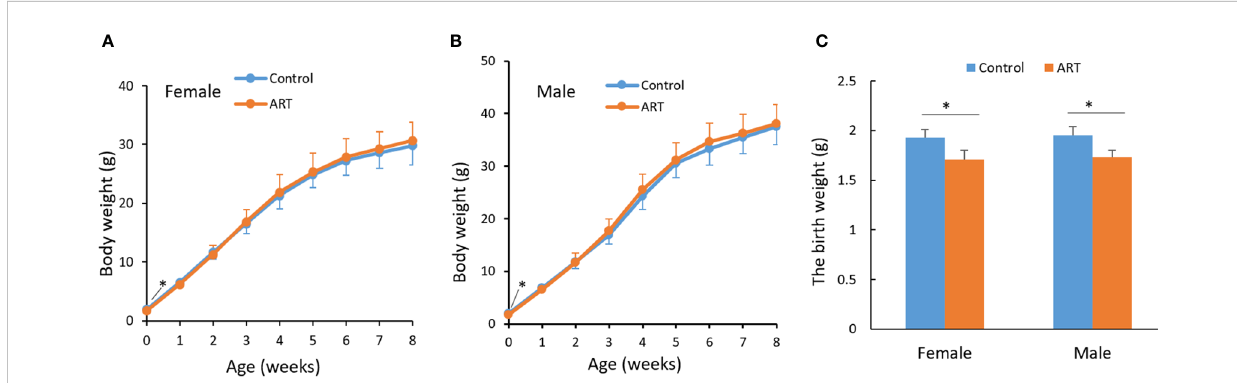
FIGURE 1 Growth curve of mice within eight weeks after birth. (A) Body weight of female offspring; (B) body weight of male offspring; (C) a histogram showing the birth weight of the offspring mice. Blue and orange lines represent the control group and ART group respectively. N equals 10 in all groups. Values are means ± SD. “ * ” represents a statistically signi fi cant difference by t-test (p < 0.05).